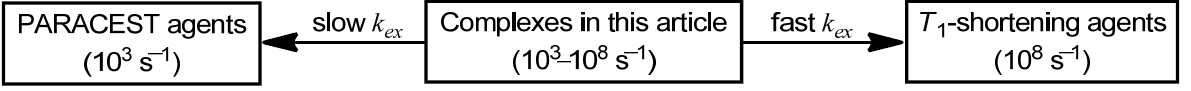
Figure 1. Optimum water-exchange rates of T